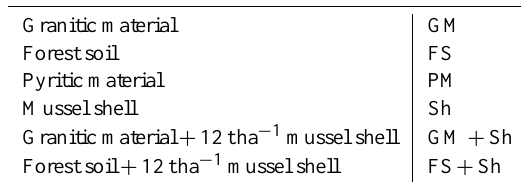
Table 1. Materials investigated and abbreviations used to designate